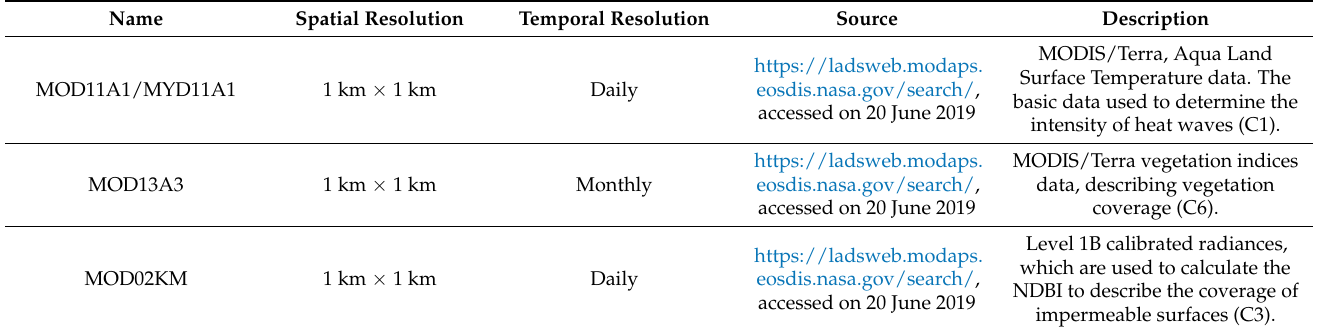
Table 1. Descriptions of the